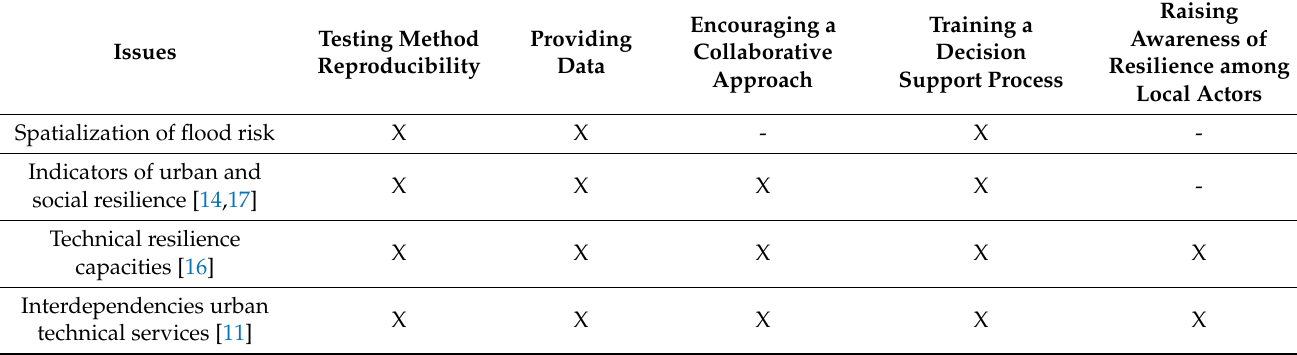
Table 1. Synthesis of the objectives of the operationalization of territorial resilience in French